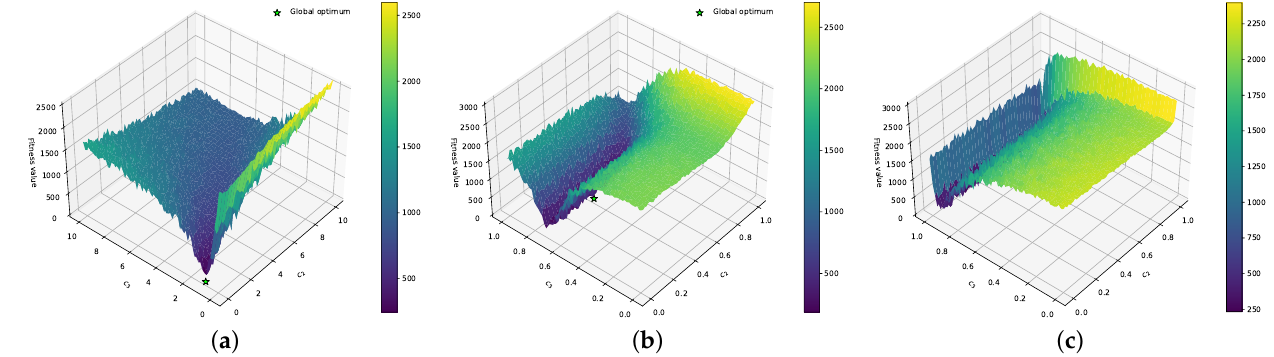
Figure 6. Effect of DFs on the fitness landscape of the MM model. ( a ) Original fitness landscape. ( b ) Fitness landscape dilated by means of the analytical anti-log DF. ( c ) Fitness landscape dilated by means of the optimal evolved